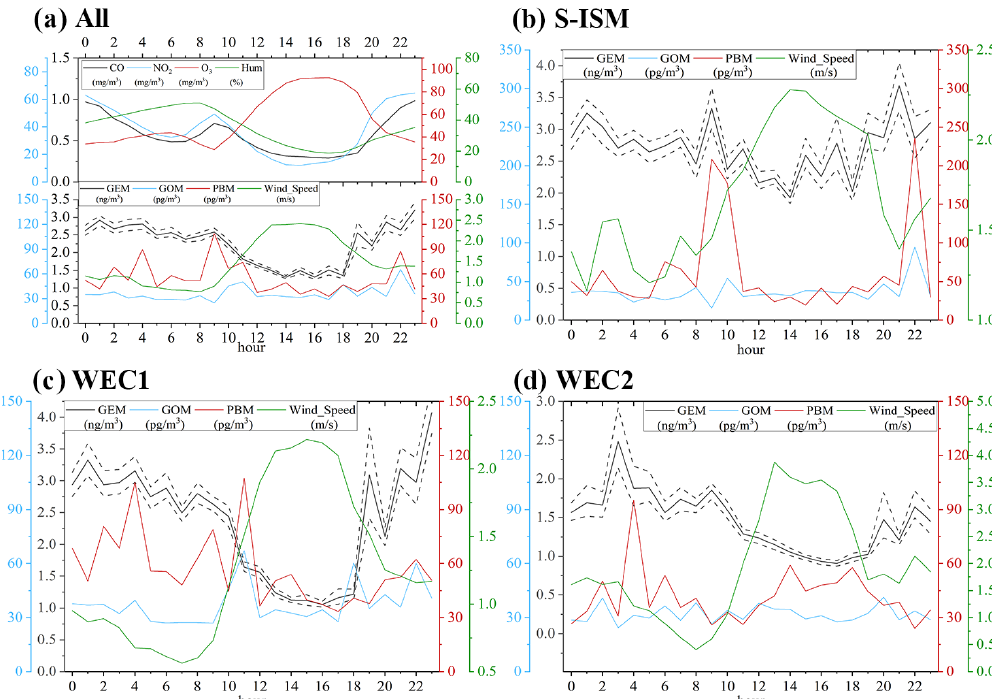
Figure 4. Diurnal variations of Hg species, concentrations of other pollutants, and meteorological information from S-ISM to WEC periods. The short horizontal line represents the concentration error range for each time